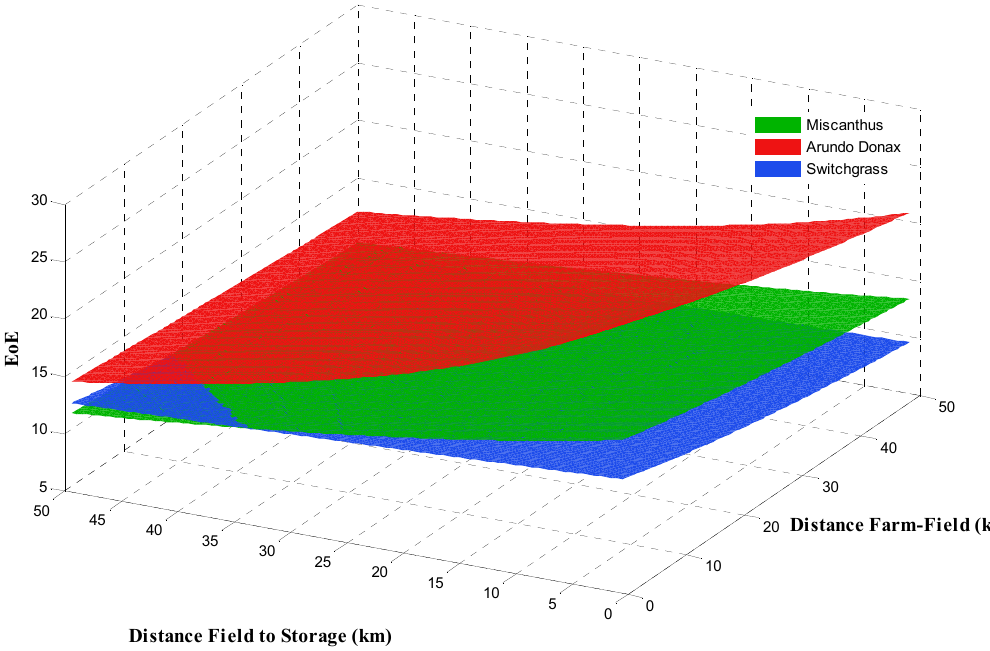
Figure 7. Efficiency of Energy variance in different distances from farm and storage facilities.